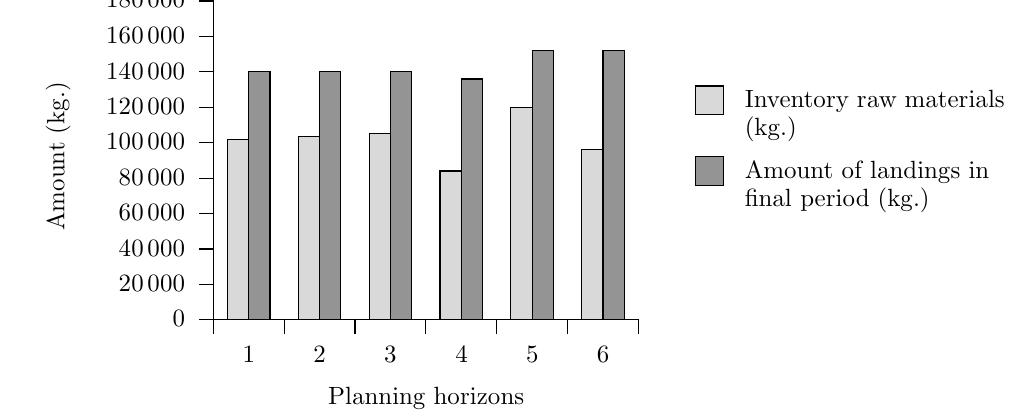
Figure 3: Comparison of final inventory levels with the kilograms of raw materials landed during the final periods of 5, 10, 15, 20, 25, and 30-period planning horizons of